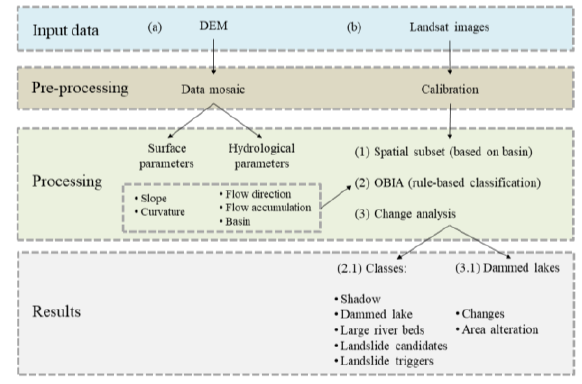
Figure 2. General methodological